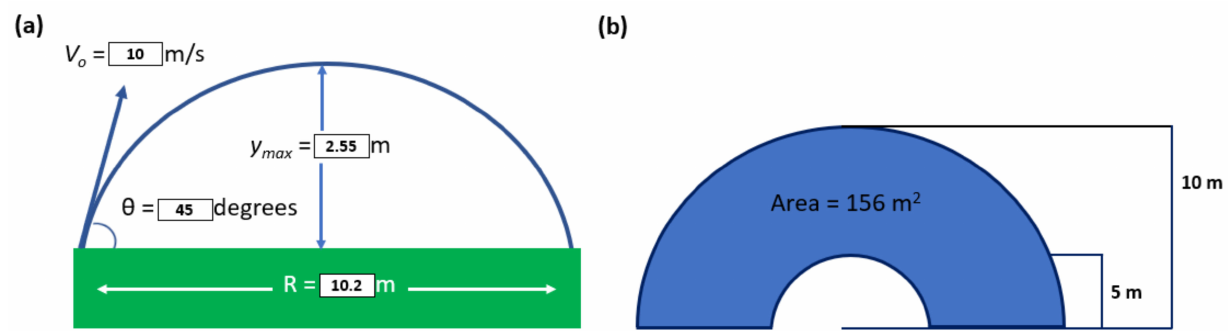
Figure 11. ( a ) Projectile motion illustration [38]; ( b ) area covered by the proposed MpSFR [38]. (Note: adopted from Author(s) own